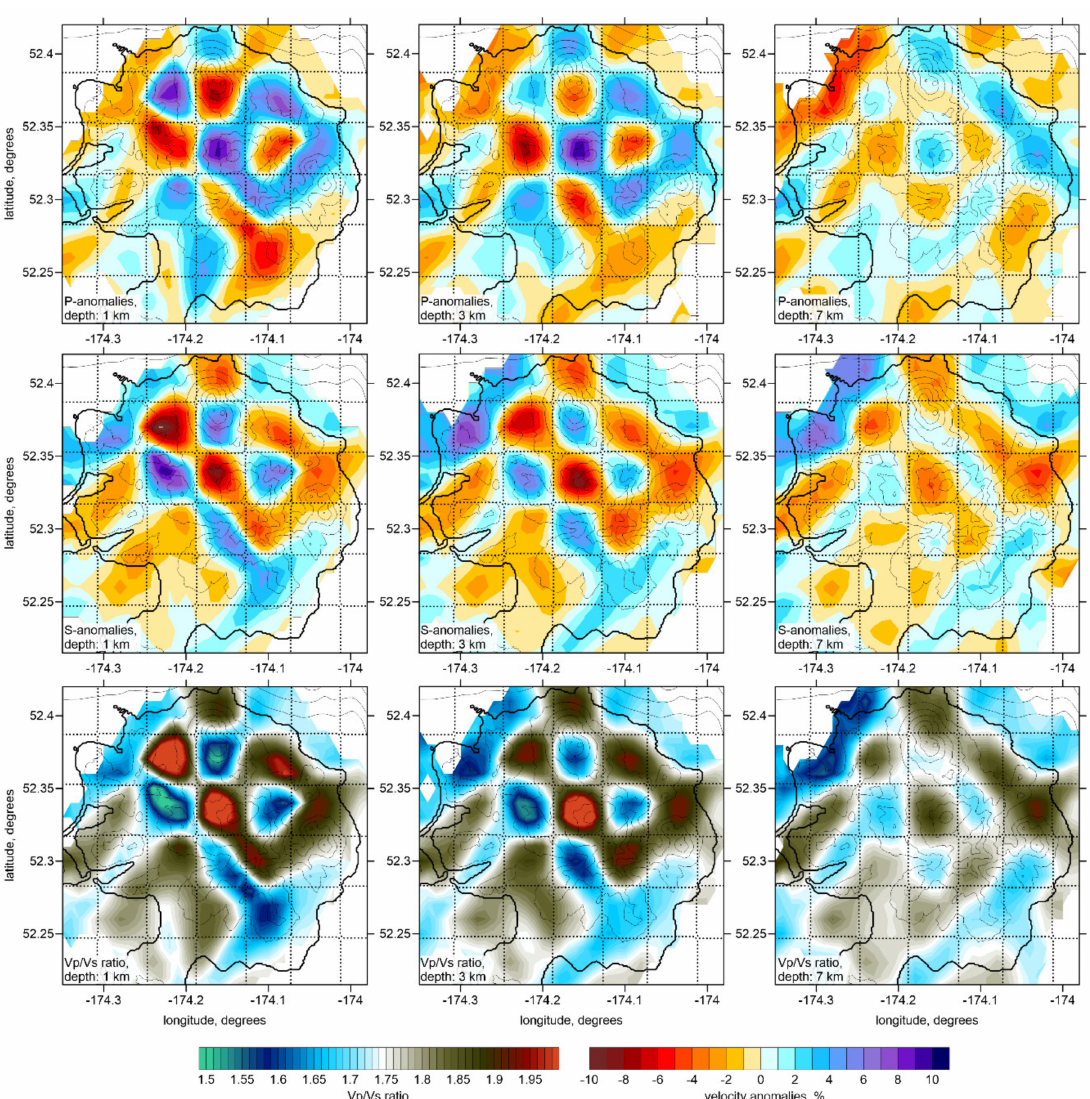
Figure 3. Checkerboard test for checking the horizontal resolution. The recovered distributions of the Vp and Vs anomalies and Vp / Vs ratio are shown in three horizontal sections. The locations of the initial anomalies are marked with dotted lines. The topography is shown with contour lines with the interval of 250